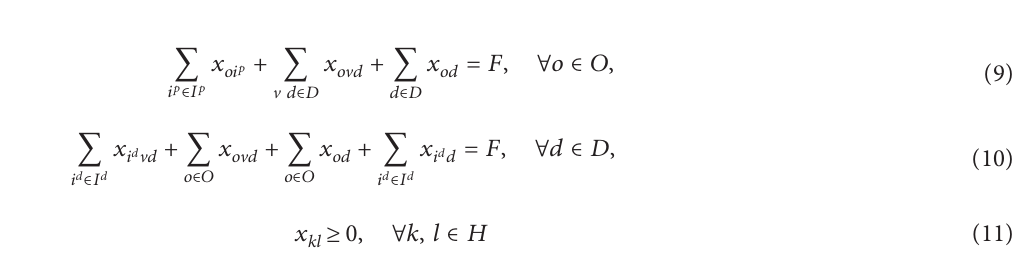
Figure 1: Links of the reservation-based SAV traffic